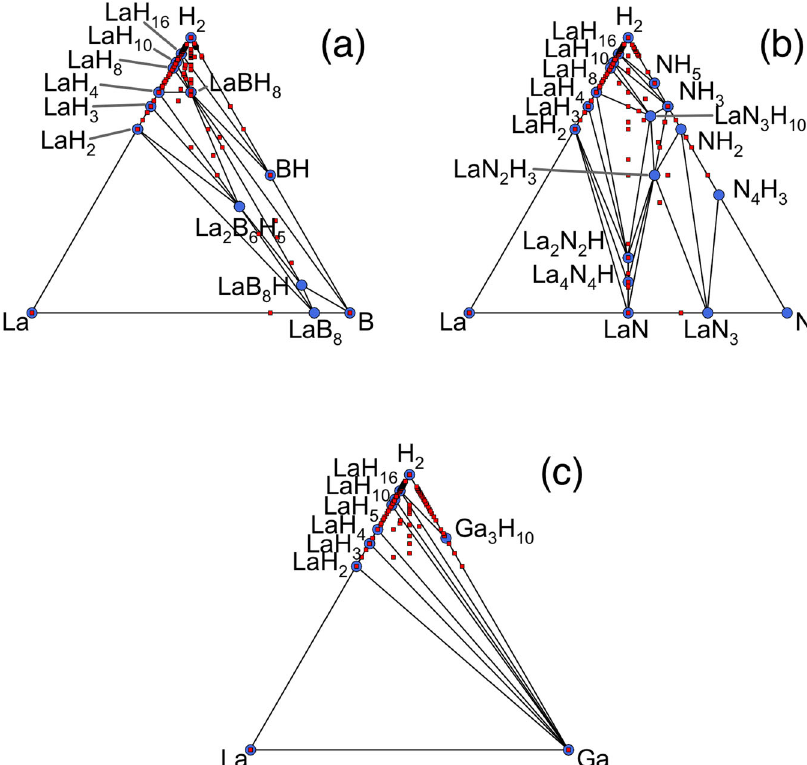
Fig. 1 Convex hulls for selected lanthanum ternary hydrides at 300 GPa. The convex hull shown are for La – N – H ( a ) and La – B-H ( b ), and La – Ga-H ( c ). Blue circles and red squares represent stable and metastable phases, respectively.